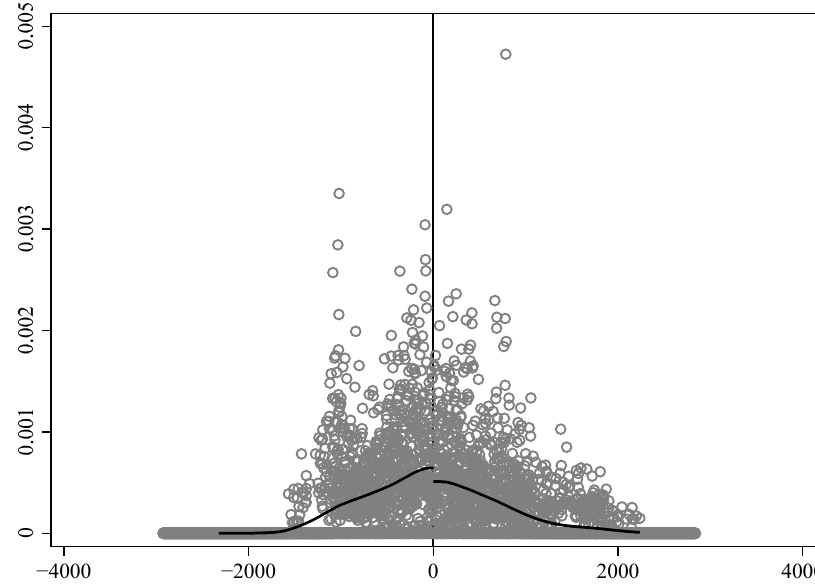
Figure A7. McCrary test of the discontinuity in distances of counties from the Huai River. Notes: The hollow circles represent the point estimates within bins. Solid lines are the density curve estimates. Table A1. Descriptive statistics.